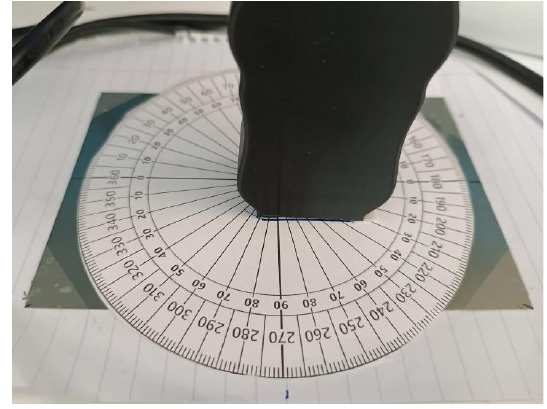
Figure 17. Experimental configuration.